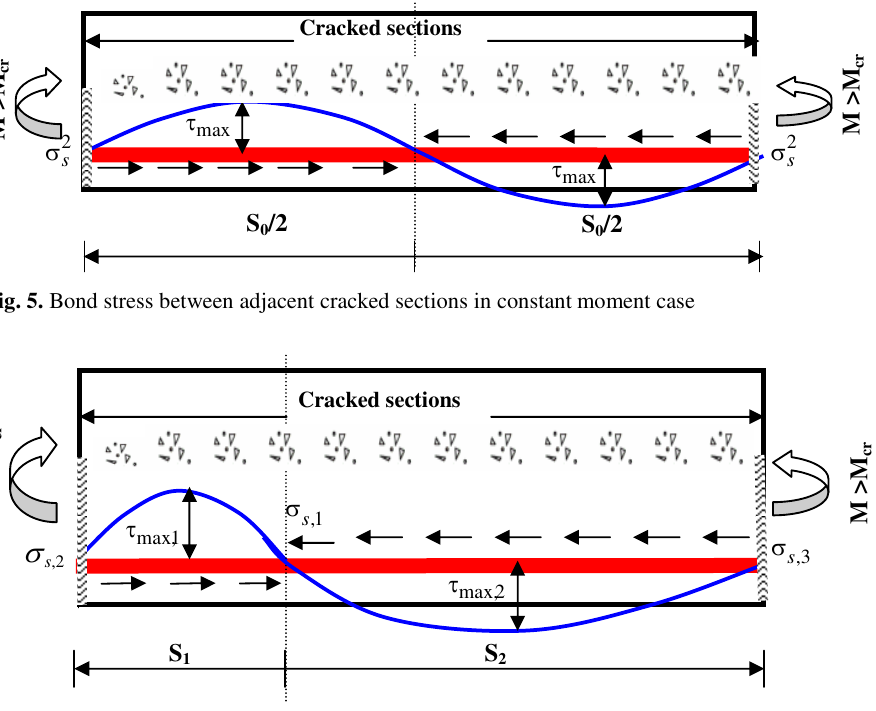
Fig. 6. Bond stress between adjacent cracked sections in varying moment case